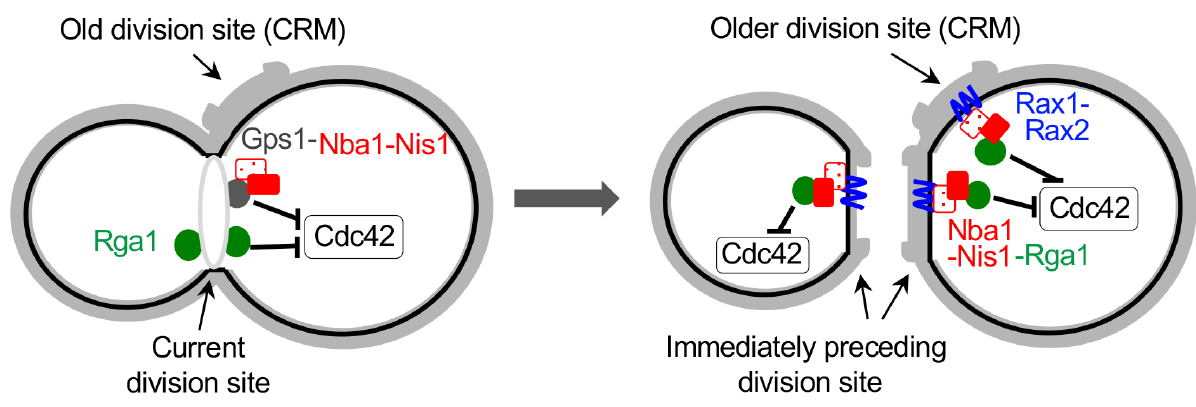
FIGURE 5: Model for inhibition of Cdc42 at the current and old cell division sites by negative polarity cues. During cytokinesis, Rga1 (green) and the Nba1-Nis1-Gps1 complex inhibit Cdc42 repolarization to the division site. After cytokinesis and septum formation, the Nba1-Nis1 complex (red) are inherited to the immediately preceding division site and remain at the older division sites (CRMs) via interaction with Rax1/Rax2 (blue lines). Rga1 also localizes transiently to CRMs via interaction with Nba1-Nis1 and inhibits Cdc42 repolarization at CRMs. The complex at the old division site is omitted in the cell shown on the left. Taken from Ref.